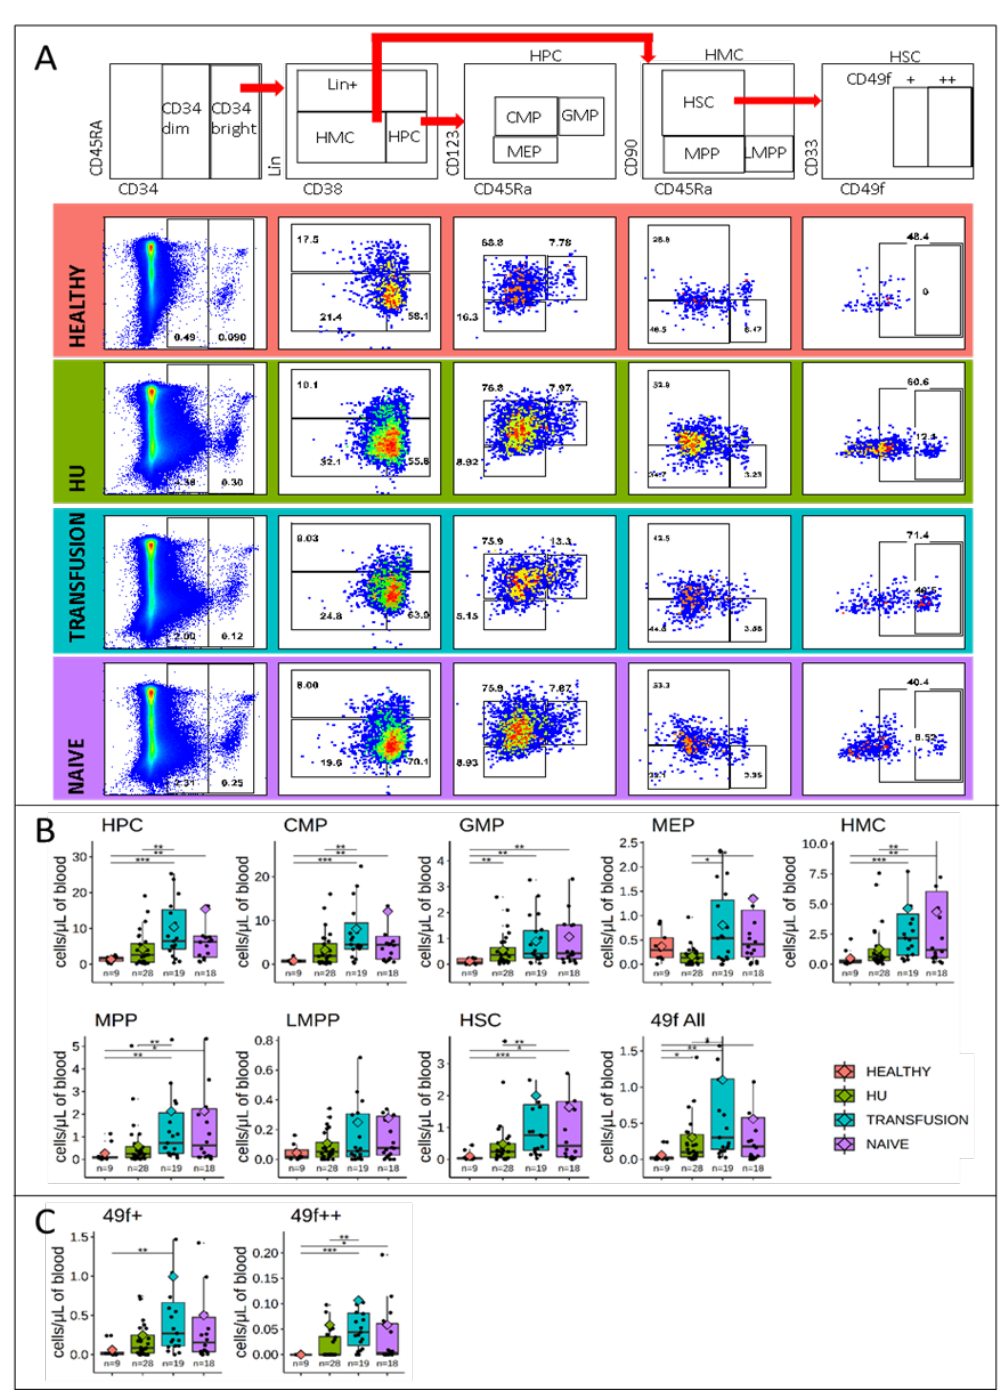
Figure 3. HSPCs characterization: ( A ) Sorting scheme and dot plots illustrating the FACS analysis. Each dot plot was generated by concatenating the FACS data obtained from all patients in the group. ( B , C ) Concentrations of HSPCs per mL of blood. Boxplots illustrate the concentration of 9 sub-populations of HSPCs in the three groups of SCD patients and in controls. Boxplots and significance are as in Figure 1. All populations except MEPs and LMPPs are in higher concentration in the SCD patients, but the HU-treated patients are closer to the controls than the other two SCD groups, suggesting that treatment with HU partially normalizes the circulating HSPC concentrations. * p ≤ 0.05; ** p ≤ 0.01; *** p ≤